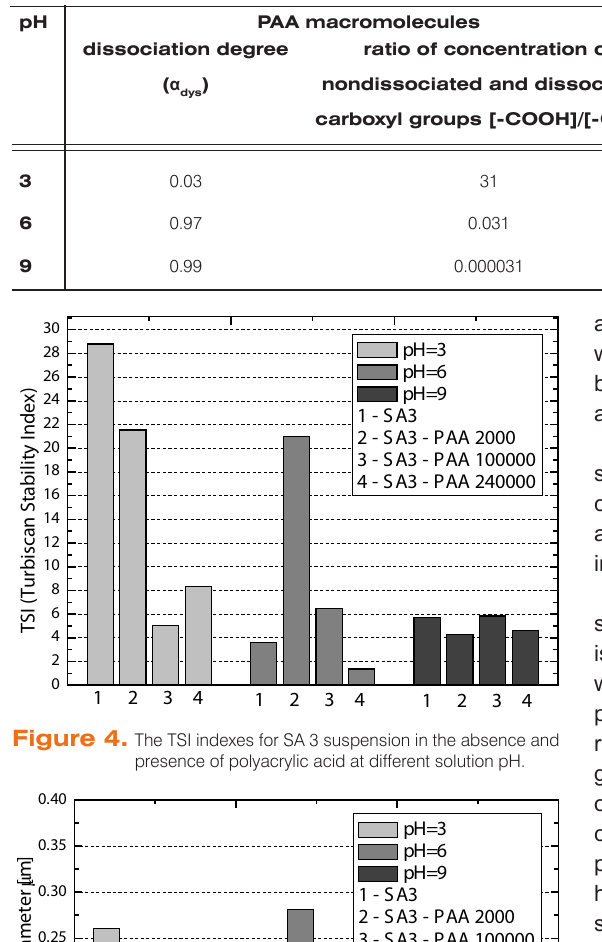
0.000.050.10 Figure 5. The average diameter of aggregates (flocs) in SA 3 suspension in the absence and presence of polyacrylic acid at different solution